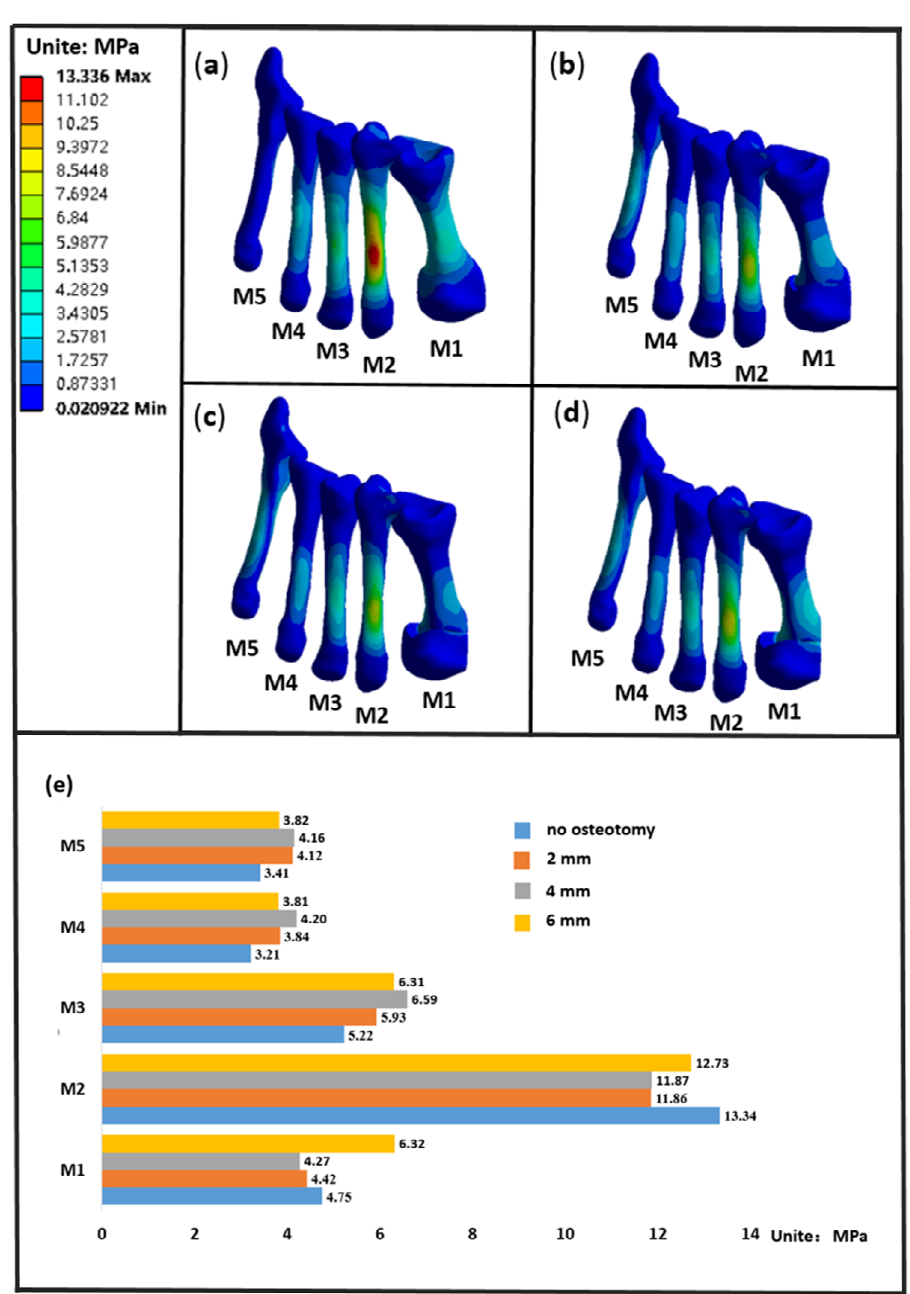
Figure 5. ( a – d ) is the stress distribution of metatarsal bone no osteotomy, 2 mm, 4 mm, 6 mm, re- spectively, ( e ) is the maximum stress of each metatarsal. M1-M5 is the first to fifth metatarsals,